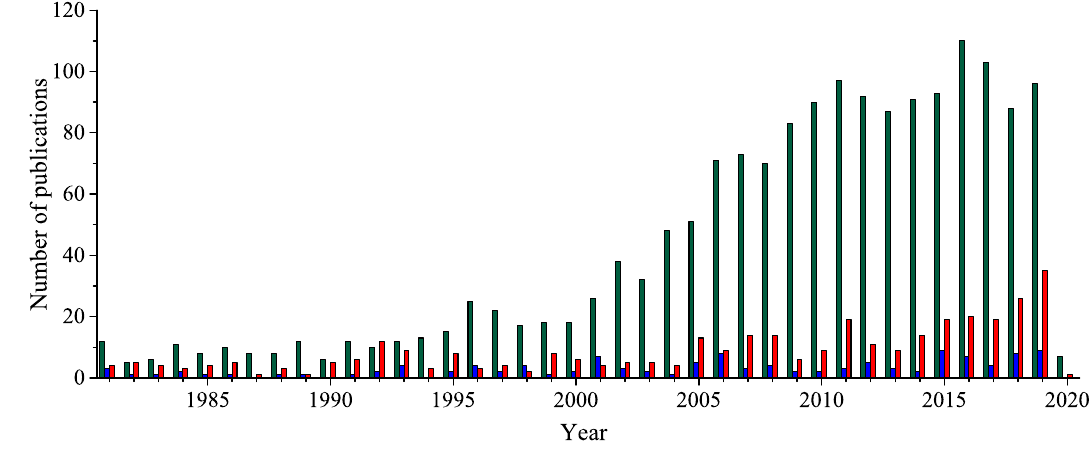
Figure 2. Number of publications containing the keywords: “1,2,4-oxadiazole” (red), “1,2,5-oxadiazole” (blue) and “1,3,4-oxadiazole” (green) in their title since 1980 [6].